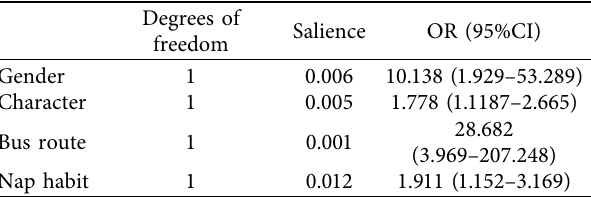
Table 21: Variables in the